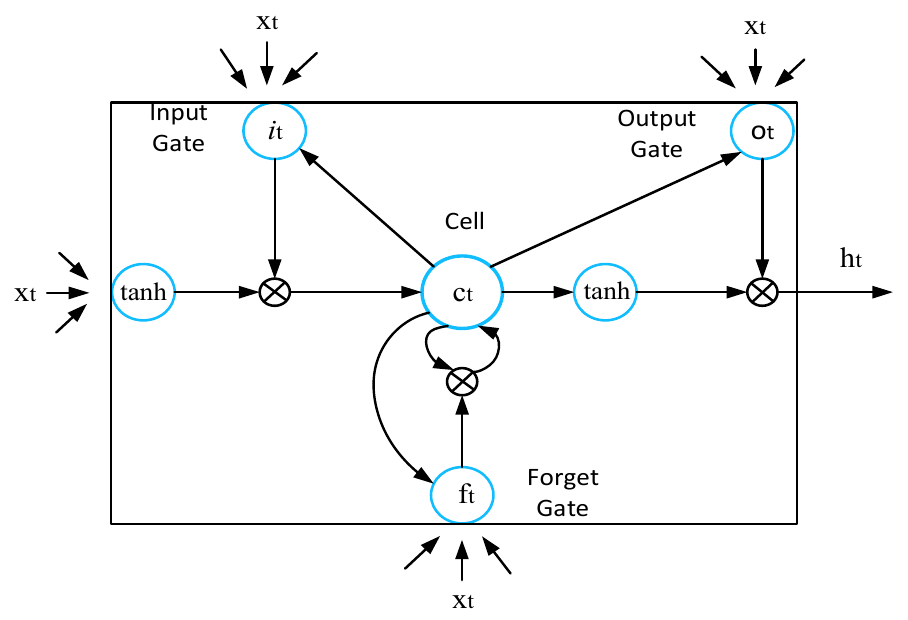
Figure 7. LSTM algorithm structure diagram.